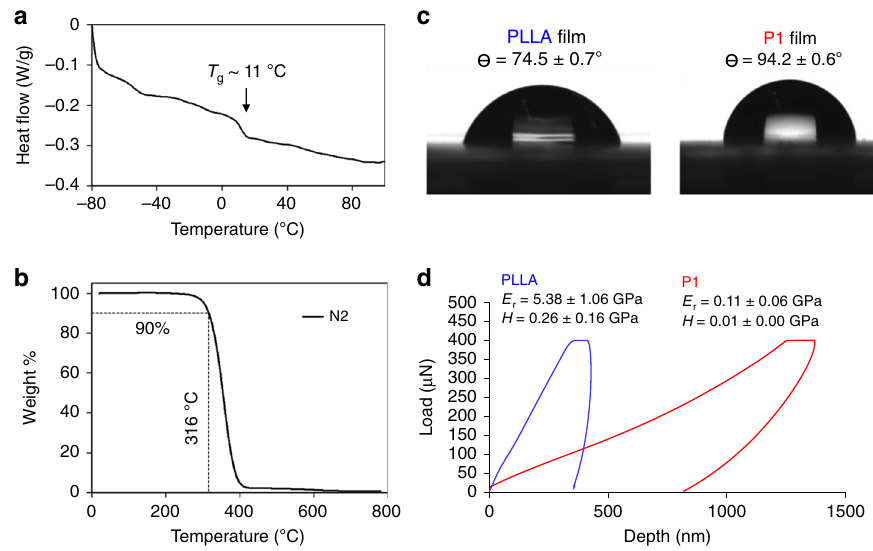
Fig. 4 Polymer fi lm characterization by a DSC, b TGA, c static water contact angle and d nanoindentation